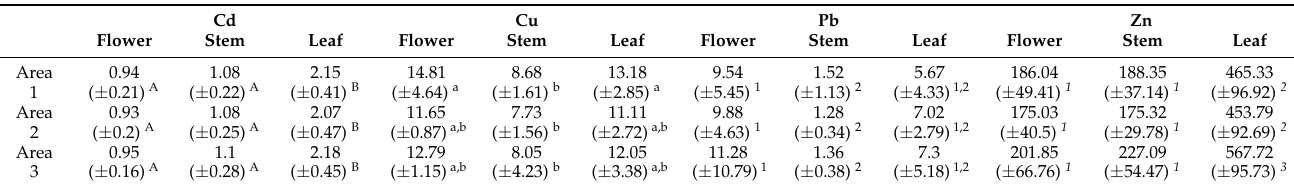
Table 3. Concentrations of Zn, Cd, Pb, and Cu ( µ g g − 1 of DW) in the flower, stem, and leaf parts of plants ( n = 10) collected from the three areas (mean + SD). For each TE and each area, the concentrations between the three parts were compared. Significant differences are indicated by different letters (lowercase, uppercase), numbers (normal, italics) at the level of α = 0.05 (Tukey HSD